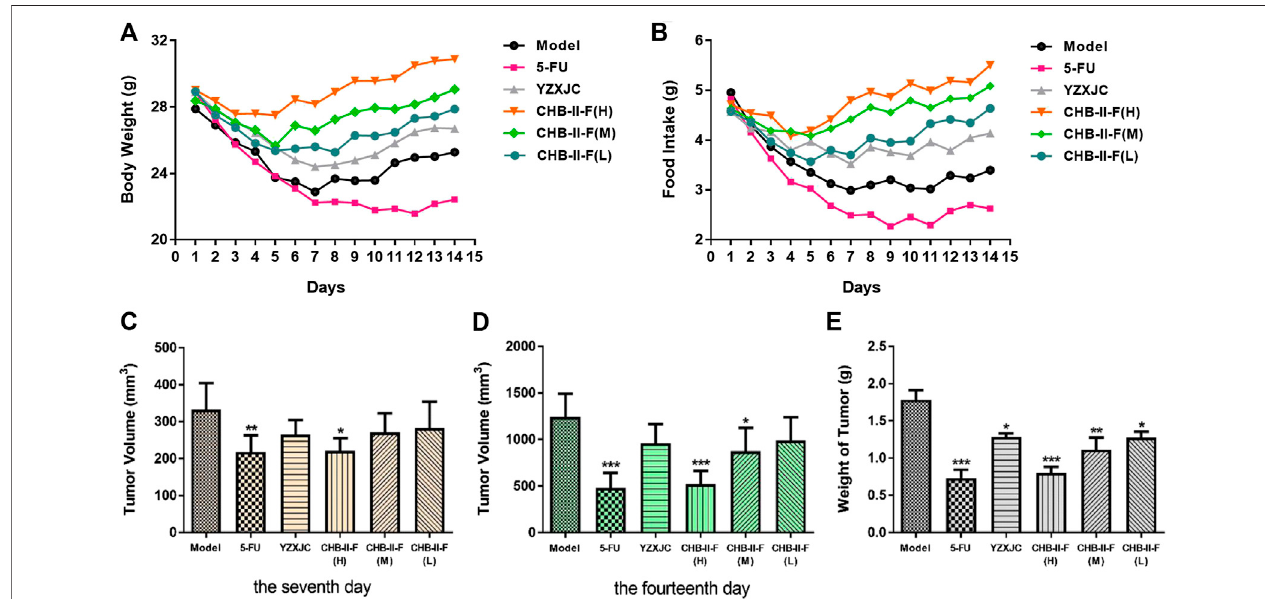
FIGURE2| EffectsofCHB-II-Fonbodyweight,intake,tumorvolume,andweightofmicewithtransplantedH 22 hepatocellularcarcinomaafterchemotherapy( x ± s , n (cid:2) 6 – 8). Statistical analysis: * p < 0.05, ** p < 0.01, *** p < 0.001 compared with the model (saline) group.